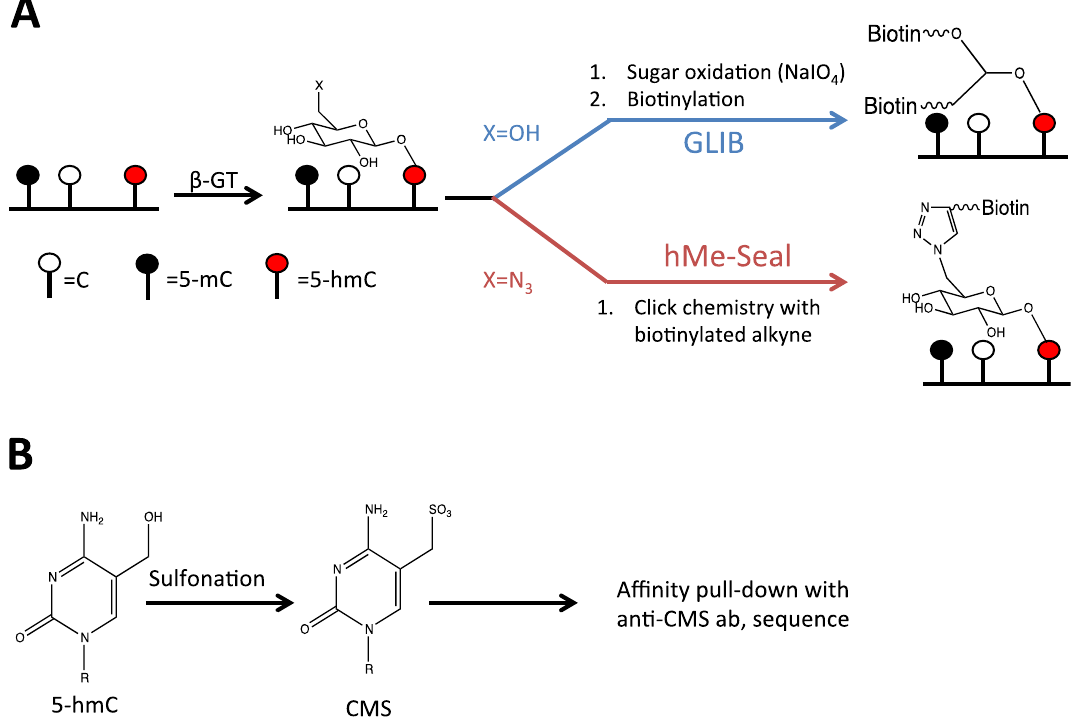
Figure 3. Techniques used to identify 5-hmC at a regional level of resolution. ( A ) In the GLIB and hME-Seal techniques for regional detection of 5-hmC, 5-hmC is first conjugated to a sugar using  -glucosyltransferase. In the GLIB technique, the conjugated sugar is glucose, whereas in the hMe-Seal technique, the glucose has been modified to carry an azide group. In the GLIB technique, the conjugated sugar is oxidized and biotinylated by nucleophilic addition of amines, whereas in the hMe-Seal technique the conjugated sugar is biotinylated through click chemistry. ( B ) Using the anti-CMS technique, 5-hmC is sulfonated with bisulfite and then pulled down using an anti-CMS